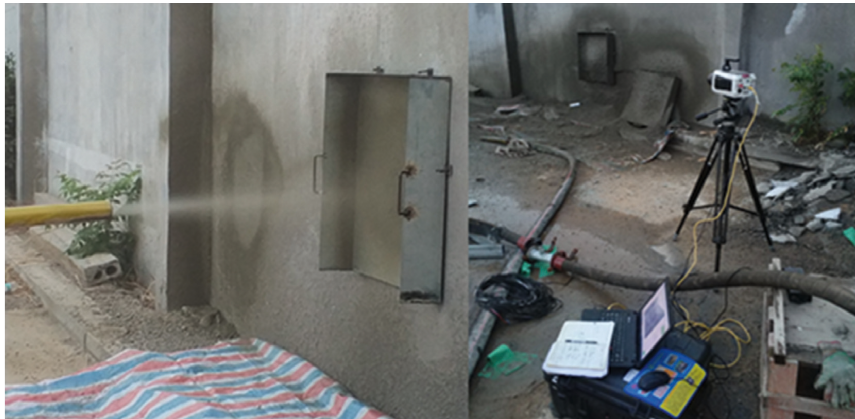
Figure 1: Using a high-speed camera to capture the jet flow process of